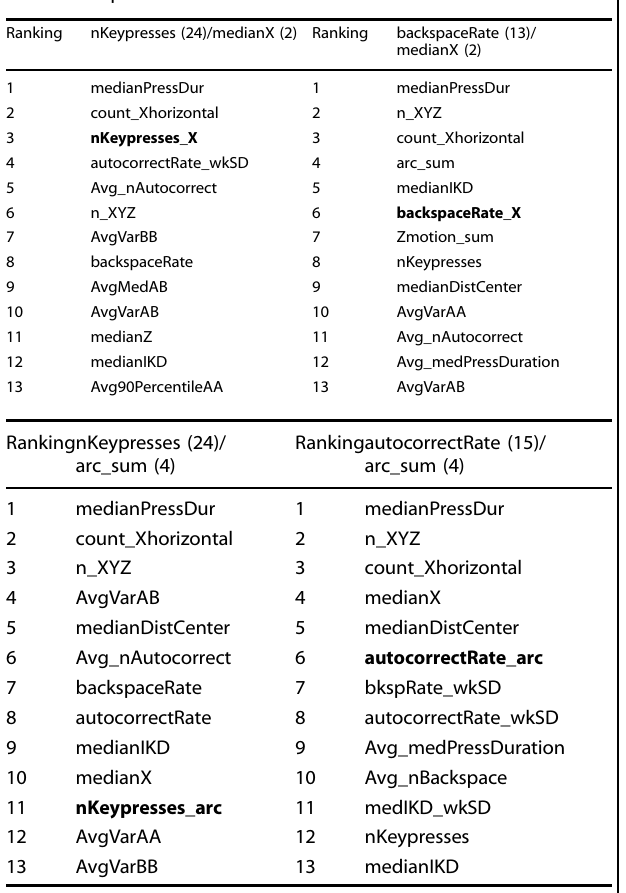
Table 7. Top features after sensor fusion a .